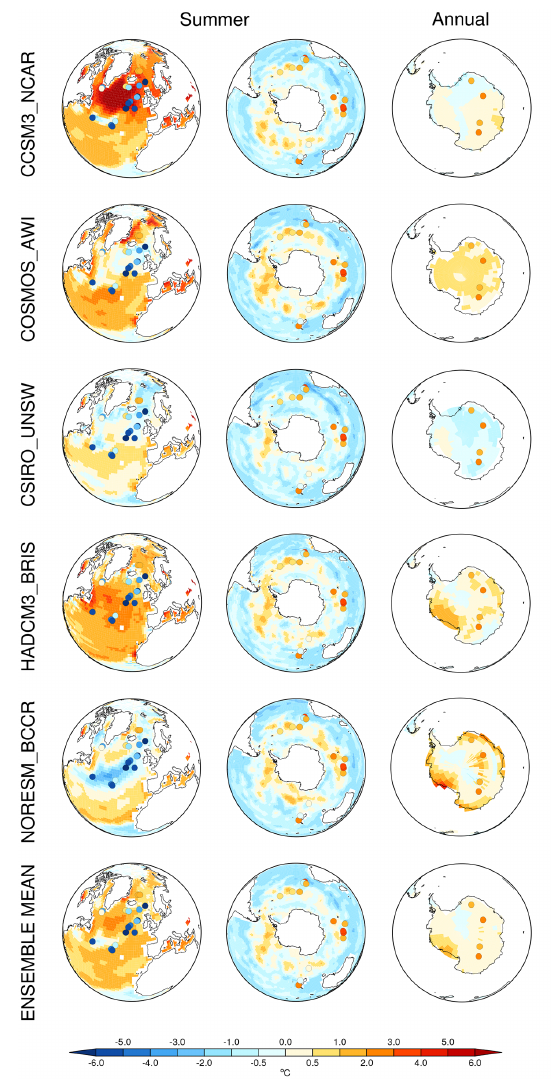
Figure 2. Simulated summer (NH July, August, September; SH January, February, March) (left and middle panels) SST and an- nual (right panel) surface air temperature change relative to pre- industrial period, for GCM model results previously published (Lunt et al., 2013) and their ensemble mean. The simulations are compared with the new data-based 130ka time slice (Capron et al.,